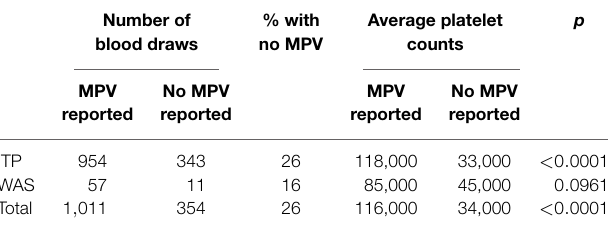
TABLE 1 | Comparison of blood draws reporting or not reporting an MPV in subjects with a diagnosis of ITP, in subjects with WAS, and in all subjects . Number of blood